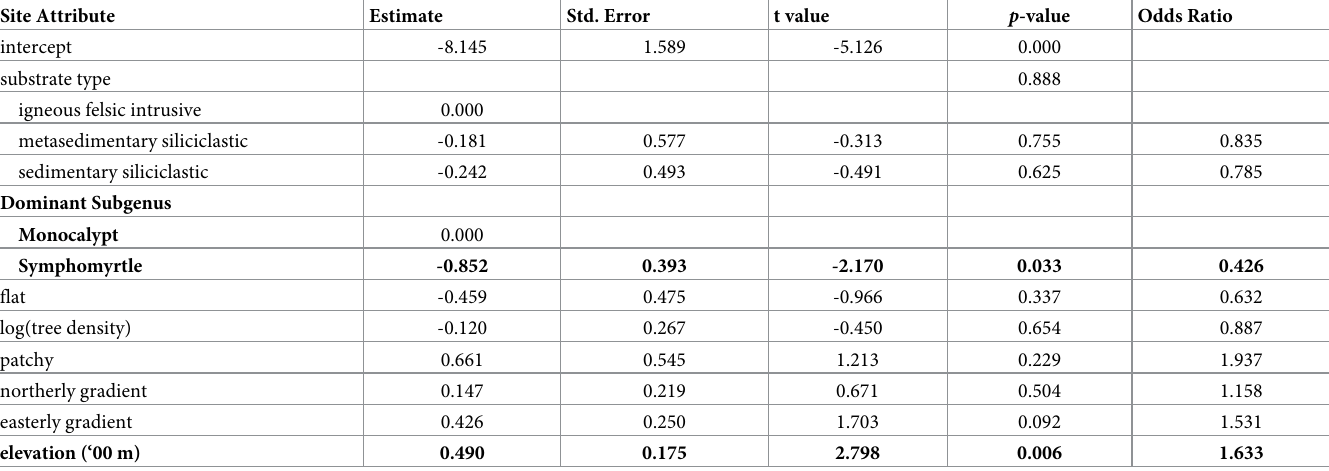
Table 2. Fitted beta-binomial regression model with dependent variable the number of moderate or more chewed trees at a